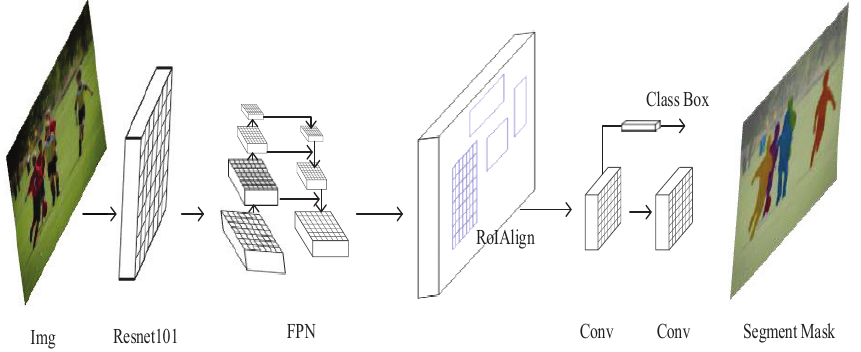
Figure 2. FPN + Mask R-CNN network framework.